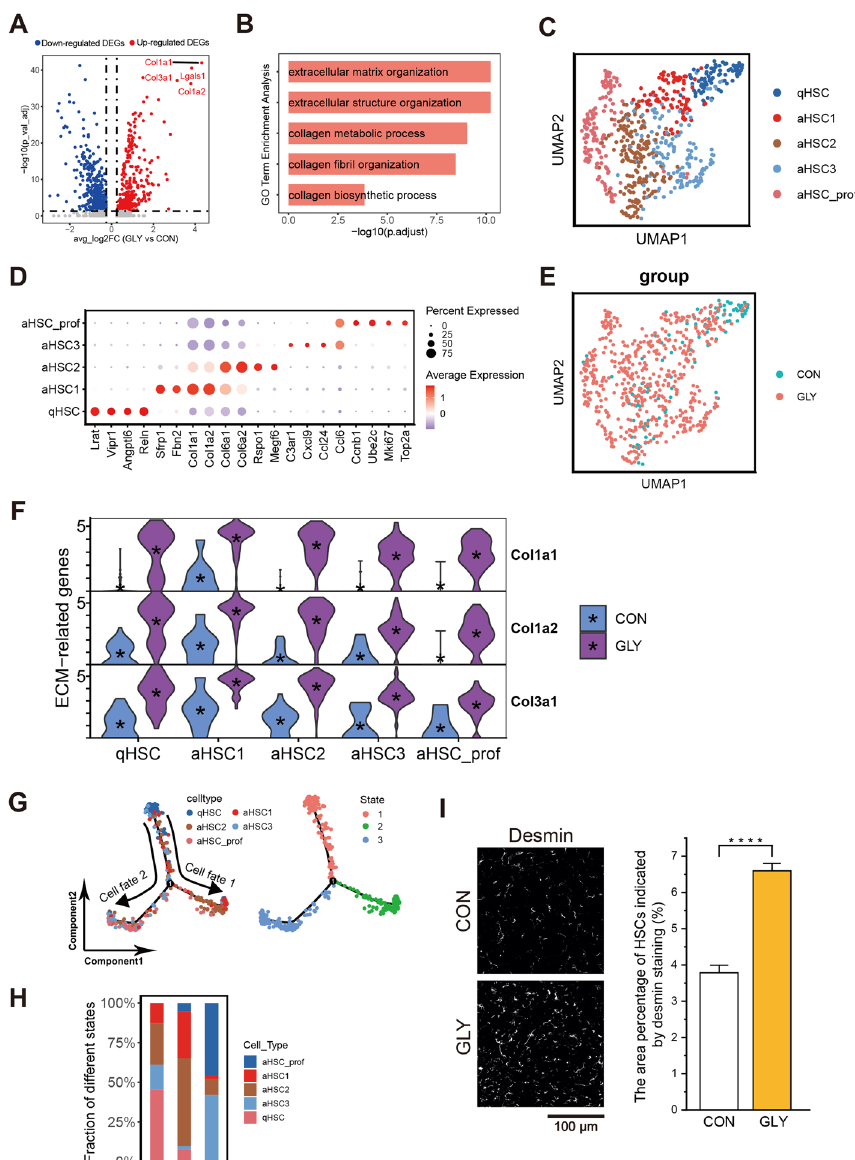
Fig. 2 Transcriptomic changes of HSC activation after GLY stimulation. A Volcano plot of genes differentially expressed between control and GLY-treated HSCs. B GO analysis for upregulated DEGs of total HSCs after GLY treatment. C UMAP plot showing the cell subtypes of HSCs. D The expression of specific marker genes identified HSC subtypes. E Merged UMAP plot for control and GLY groups. F Violin plots of the expression for three genes associated with ECM. G Pseudotime trajectory analysis of HSC subtypes. H Proportion changes of each cell type for different states during the pseudotime analysis. I Typical images and bar graph showing the increased area percentage of Desmin after GLY treatment. Scale bar, 100 μm; Error bar, mean deviation (SD); P value is from Student’s t test (unpaired and two-tailed); **** P was based on six random areas from each